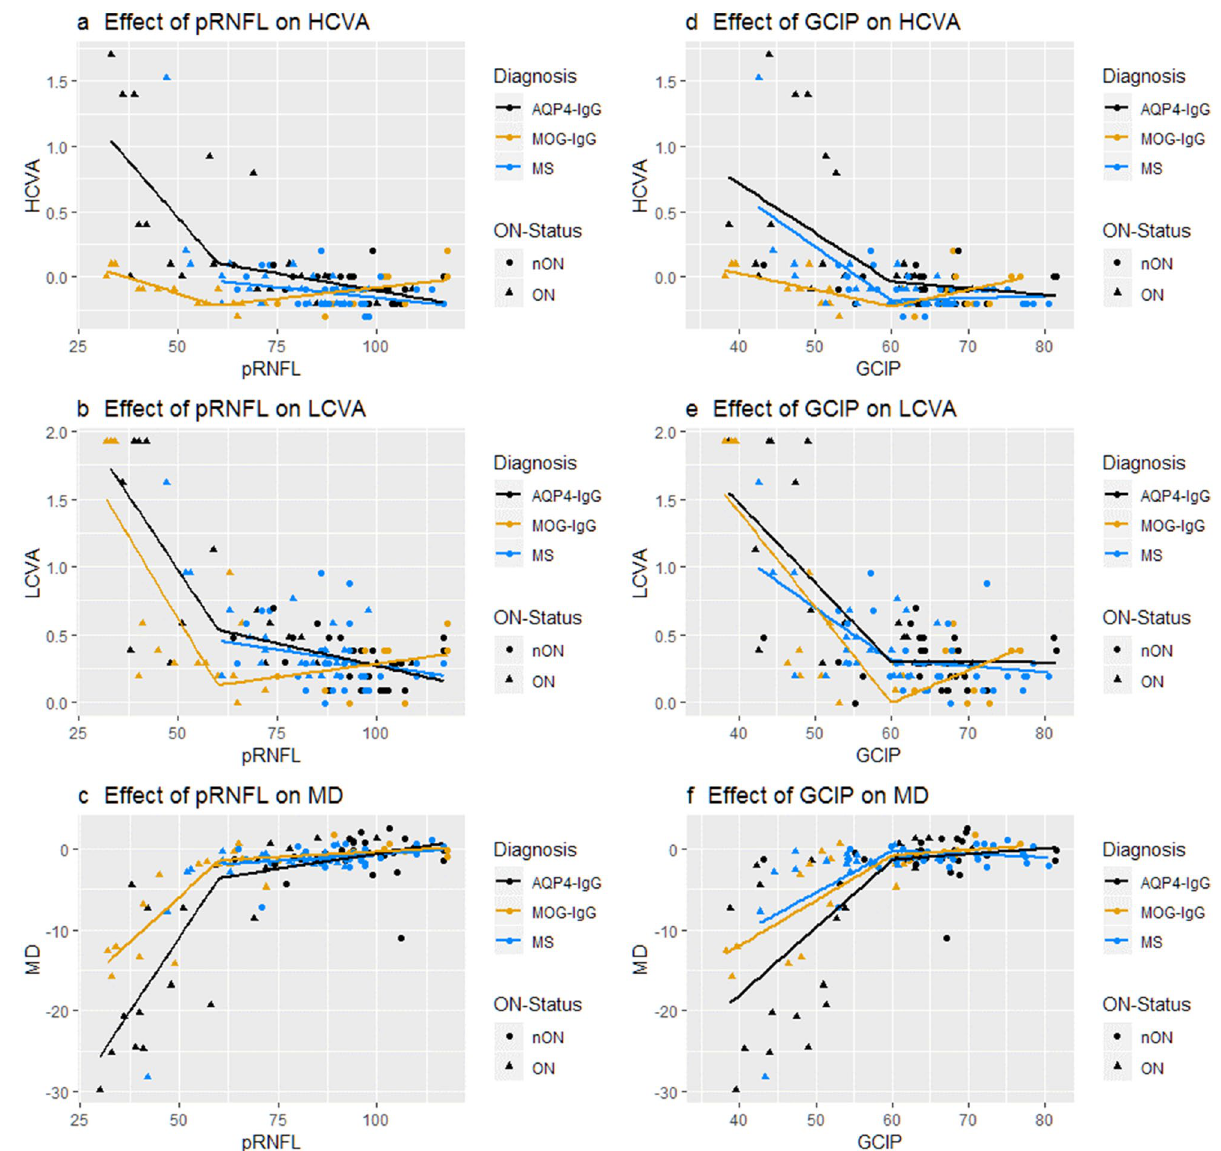
Figure 2. Association between visual function and retinal structures. ( a – c ): Effect of pRNFL thickness on ( a ) high contrast visual acuity, ( b ) low contrast visual acuity, ( c ) mean deviation of visual fields; ( d – f ): Effect of GCIP thickness on ( d ) high contrast visual acuity, ( e ) low contrast visual acuity ( f ) mean deviation of visual fields. Effects were modelled with a linear spline model; knot location was chosen to be 60 µm for both pRNFL and GCIP models following subjective visual assessment. AQP4-IgG: Aquaporin-4-IgG seropositive patients; MOG-IgG: Myelin-Oligodendrocyte-Glycoprotein-IgG seropositive patients; MS: Multiple Sclerosis patients; HCVA: High contrast visual acuity; LCVA: Low contrast visual acuity; MD: mean deviation; pRNFL: peripapillary retinal nerve fibre layer; GCIP: ganglion cell and inner plexiform such difference between NMOSD and MS eyes. However, when inspecting the corresponding plot, one must note that the results for MS-eyes are heavily skewed by a single MS-ON eye with far outlying visual function. This eye belongs to a patient with a single severe ON episode leading to blindness. When excluding this eye, MS-eyes would show a trend of a less steep loss of HCVA than NMOSD-eyes (Beta = 0.022 SE = 0.012; p = 0.07). None of the patient groups showed a relevant association between inner rim volume and any measure of visual function above the cutoff point of 0.1 mm 3 (Fig. 3). However, the mixed linear spline model showed a significant association of inner rim volume and LCVA (Beta = − 20.55 ± 7.72; p = 0.01), MD of visual fields (Beta = 275.26 ± 123.10; p = 0.03) and—in trend—HCVA (Beta = − 11.14 ± 6.24; p = 0.08) in AQP4-IgG seropositive NMOSD eyes. MOGAD eyes did not show an identifiable pattern in the relationship between inner rim volume and visual function. MS eyes had a significant association between high contrast acuity and inner rim volume below the 0.1 mm 3 cutoff (Beta = − 11.29 ± 4.86; p = 0.03), which was again entirely dependent on the outlier described above. When excluding this outlier, no significant association between inner rim volume of MS-eyes